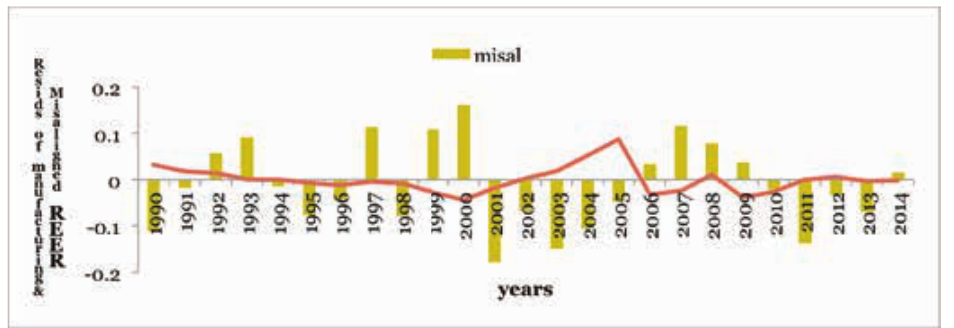
Figure 6: Overvaluation and Growth Relationship